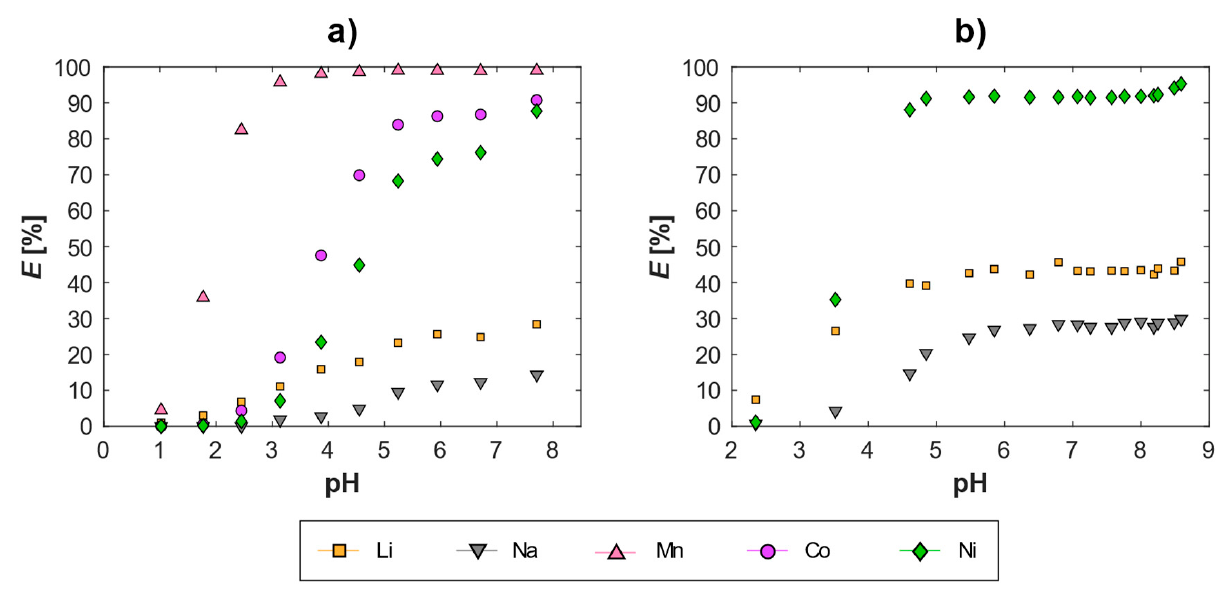
Figure 2. The effect of pH on the extraction of Li, Ni, Co, Mn, and Na by 0.8 M D2EHPA (modified by 5 vol-% TBP and diluted in Exxsol D80). T = 25 ± 1 °C; t eq = 15 min; O/A = 1. Initial aqueous concentrations [g L − 1 ]: ( a ) Li: 2.52; Ni: 2.05; Co: 16.5; Mn: 2.09; ( b ) Li: 2.29; Na: 26.2; Ni: 1.94.